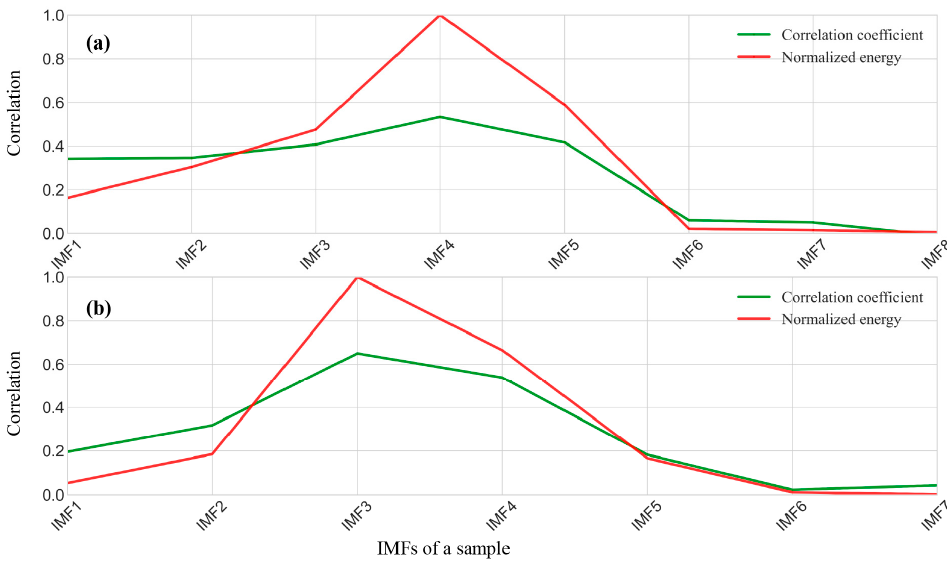
Figure 7. The correlation coefficient between IMFs and original sampled signal and normalized en ‐ ergy of IMFs: ( a ) Bateero, ( b ) PirataSalvora.